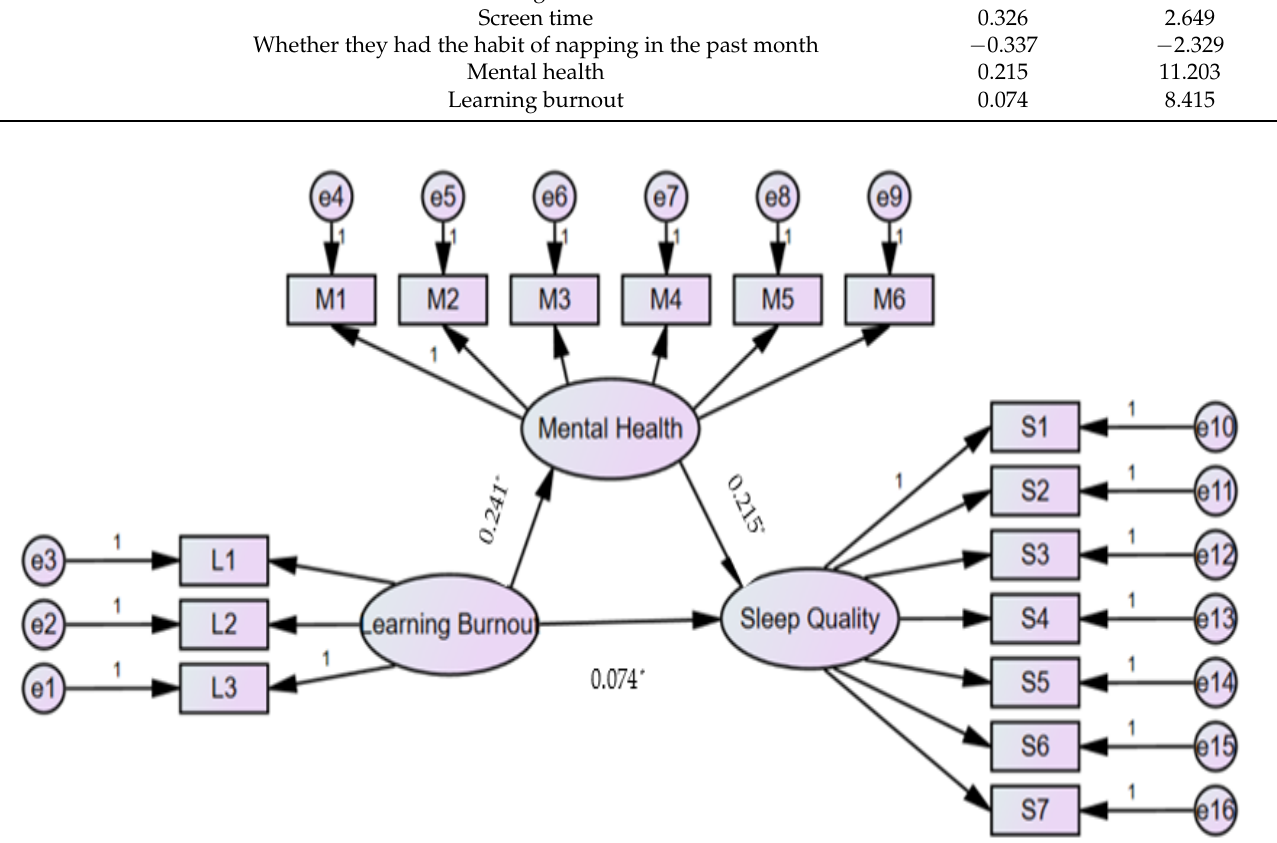
Figure 1. Mediating role of mental health. Note: L1, L2, and L3 are the three dimensions of learning burnout, respectively; M1–M6 are the 6 questions of K6, respectively; S1–S7 are seven dimensions of sleep quality, respectively; e1–e16 are the residual error to each variable; The number 1 means that the path coefficient (i.e., the influence coefficient) has a fixed value of 1; The asterisk (*) means that the path coefficient is statistically